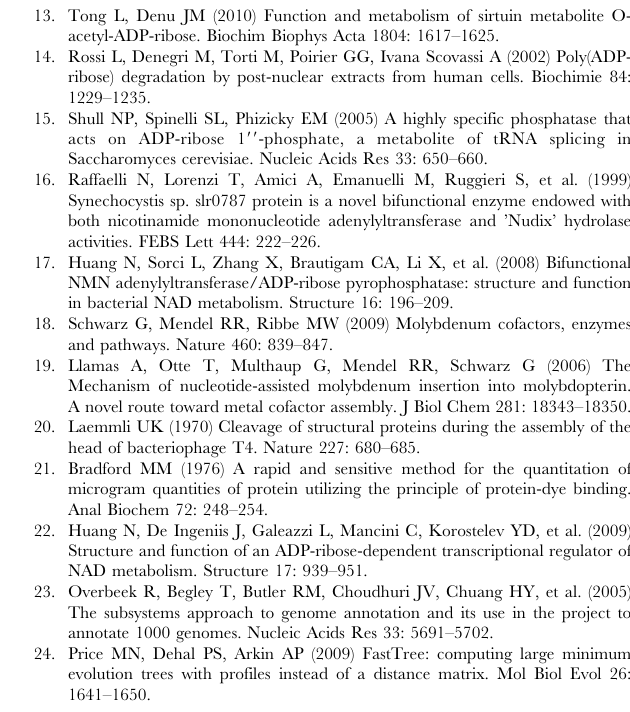
Figure S1 Phylogenetic tree of COG1058. Color notations are the same as in Figure 7. Figure S2 Multiple alignment of COG1058 sequences. (TIF) Figure S3 At COG1058 mutants characterization. SDS- PAGE (upper panel) of 8 m g and 0.8 m g of each purified protein. HPLC chromatograms (lower panel) of the reaction mixtures